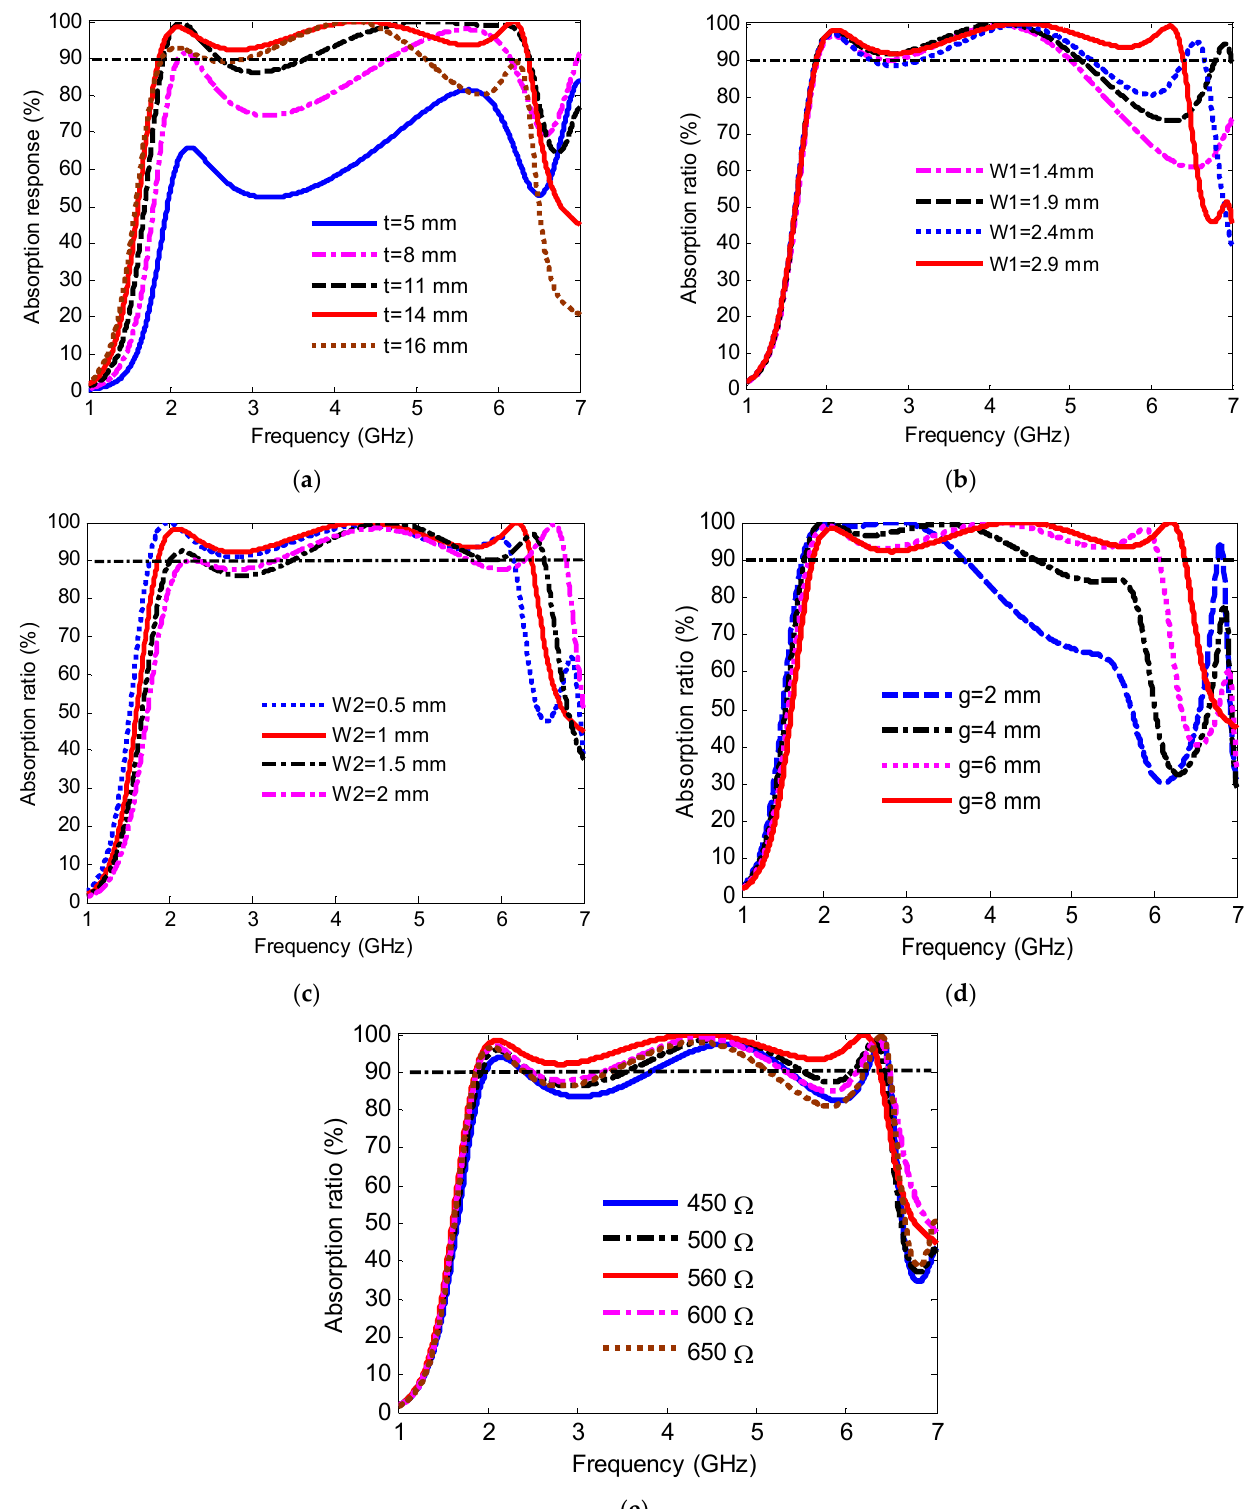
Figure 6. Simulated absorption spectra of the MS absorber: ( a ) air layer thickness, ( b ) outer resonator’s width, ( c ) inner resonator’s width, ( d ) split’s size, and ( e ) load resistor.